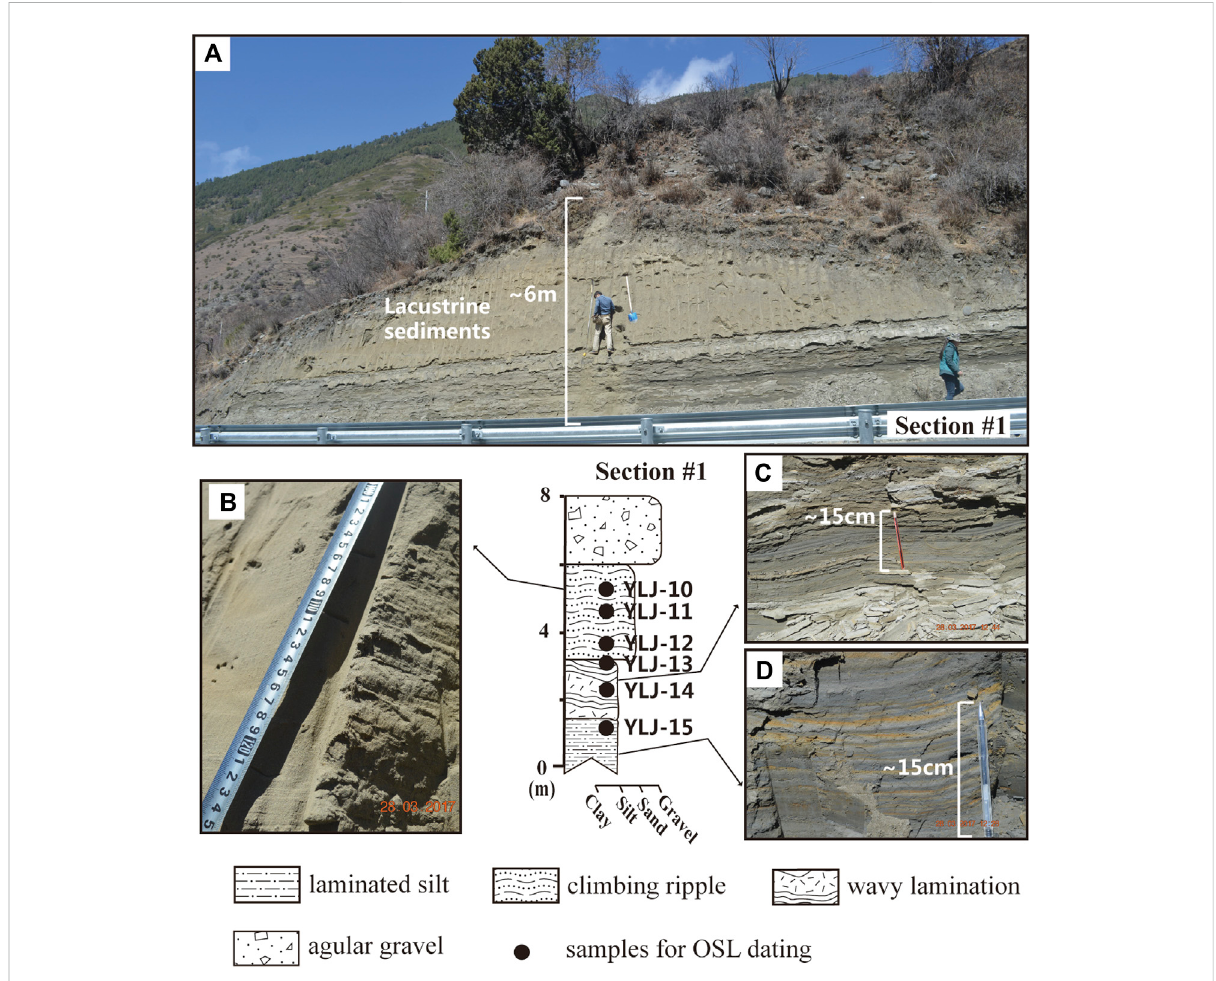
FIGURE 3 Detailed sedimentary logs and photographs of lacustrine sediment in section #1 at the Yuting landslide-dammed lake. Solid black circles and YLJsymbolsrepresentthedepthandnumberofOSLdatingsamples. (A) Panoramapictureofsection#1.Notethatthemaximumexposedthickness is 6 m. (B) Close-up photograph of climbing ripples on the top of section #1. (C) Close-up of wavy lamination in section #1. (D) Typical annual lacustrine varve